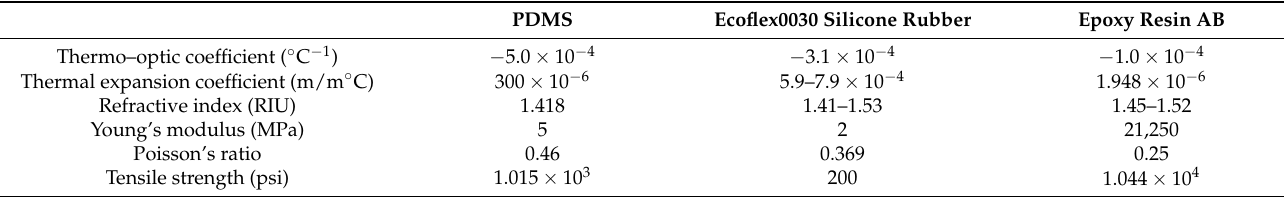
Table 1. The optic and physical properties of the diaphragms [24–29].